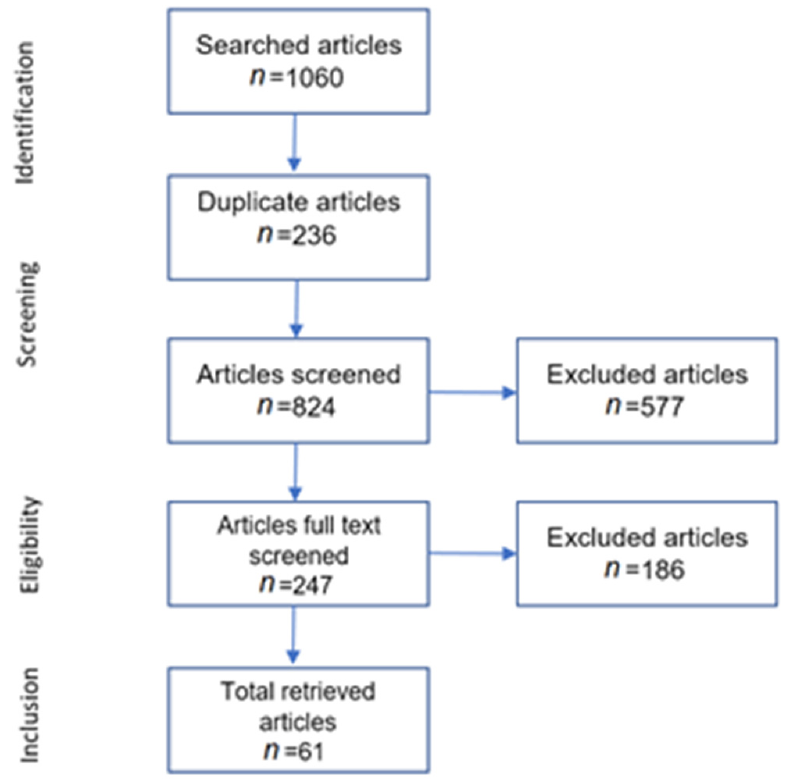
Figure 2. Diagram of PRISMA flow.